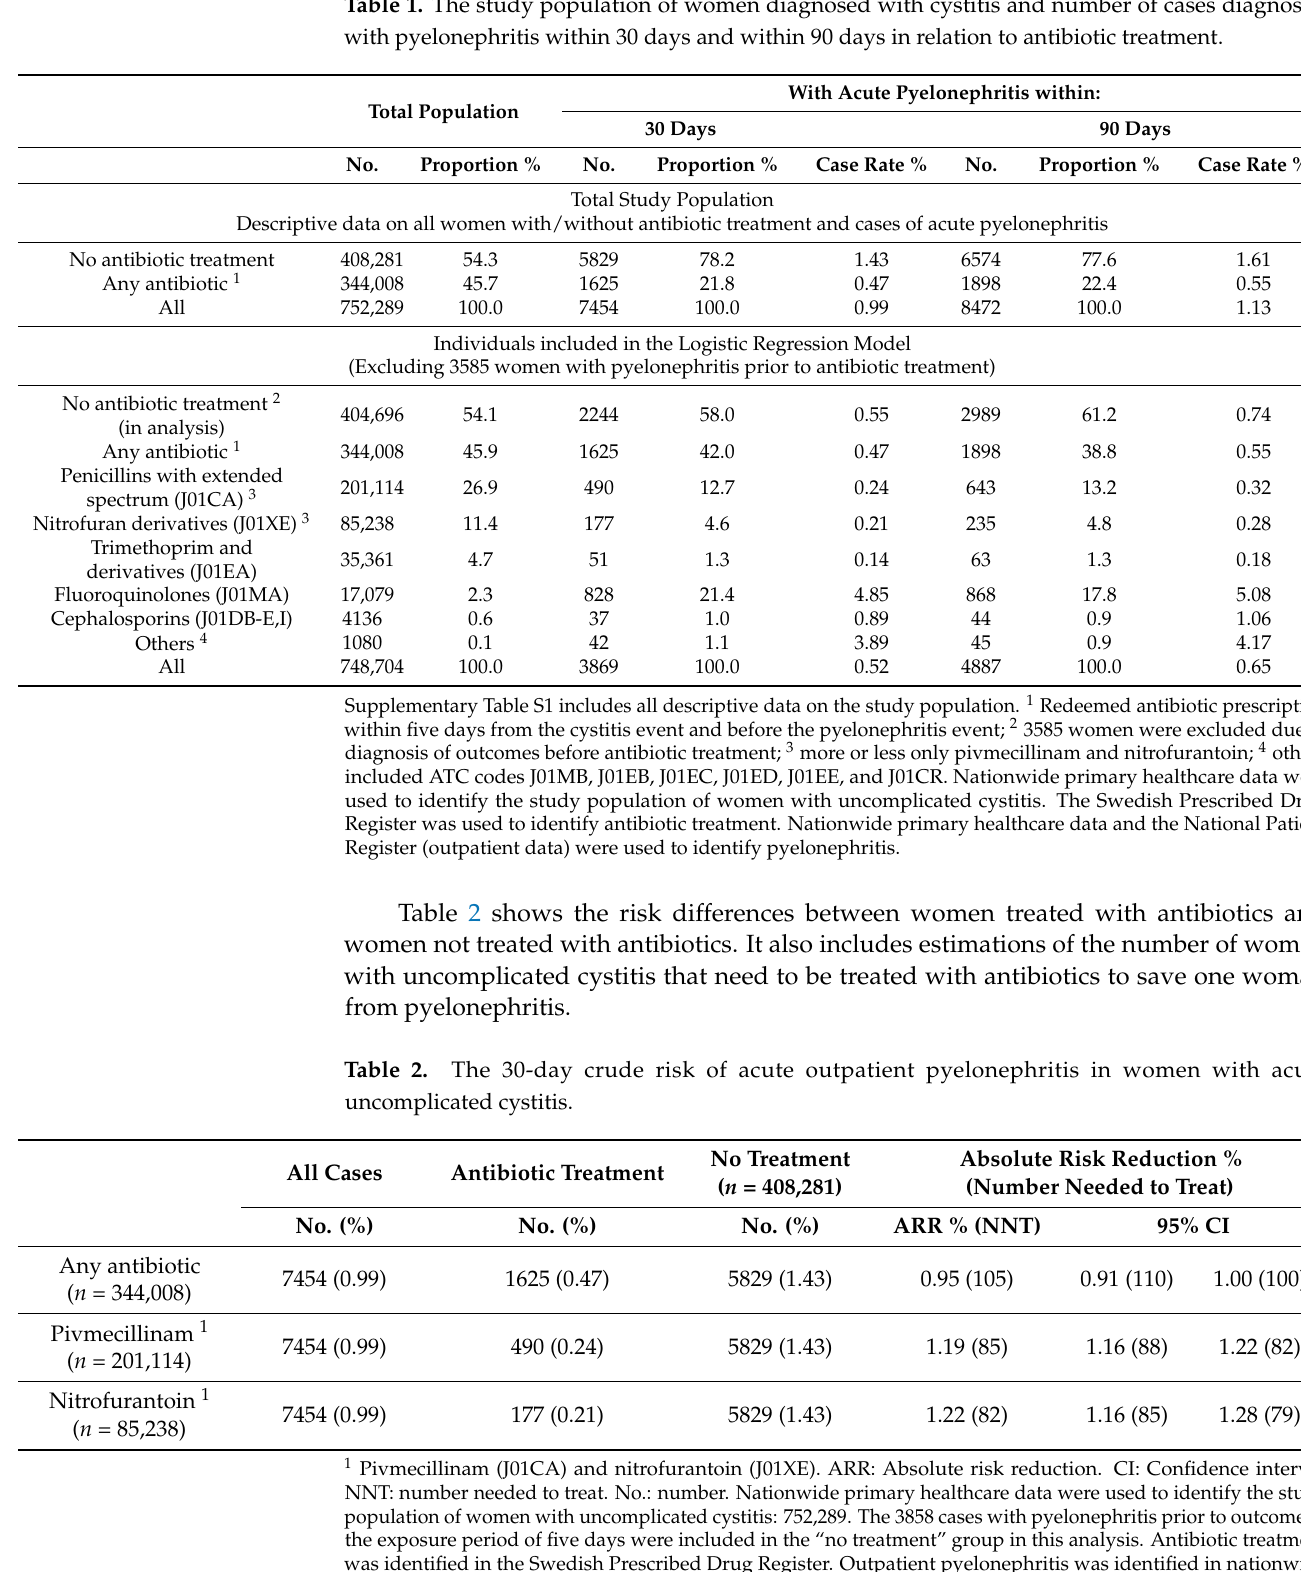
Table 1. The study population of women diagnosed with cystitis and number of cases diagnosed with pyelonephritis within 30 days and within 90 days in relation to antibiotic treatment. With Acute Pyelonephritis within: Total Population 30 Days 90 Days No. Proportion % No. Proportion % Case Rate % No. Proportion % Case Rate %